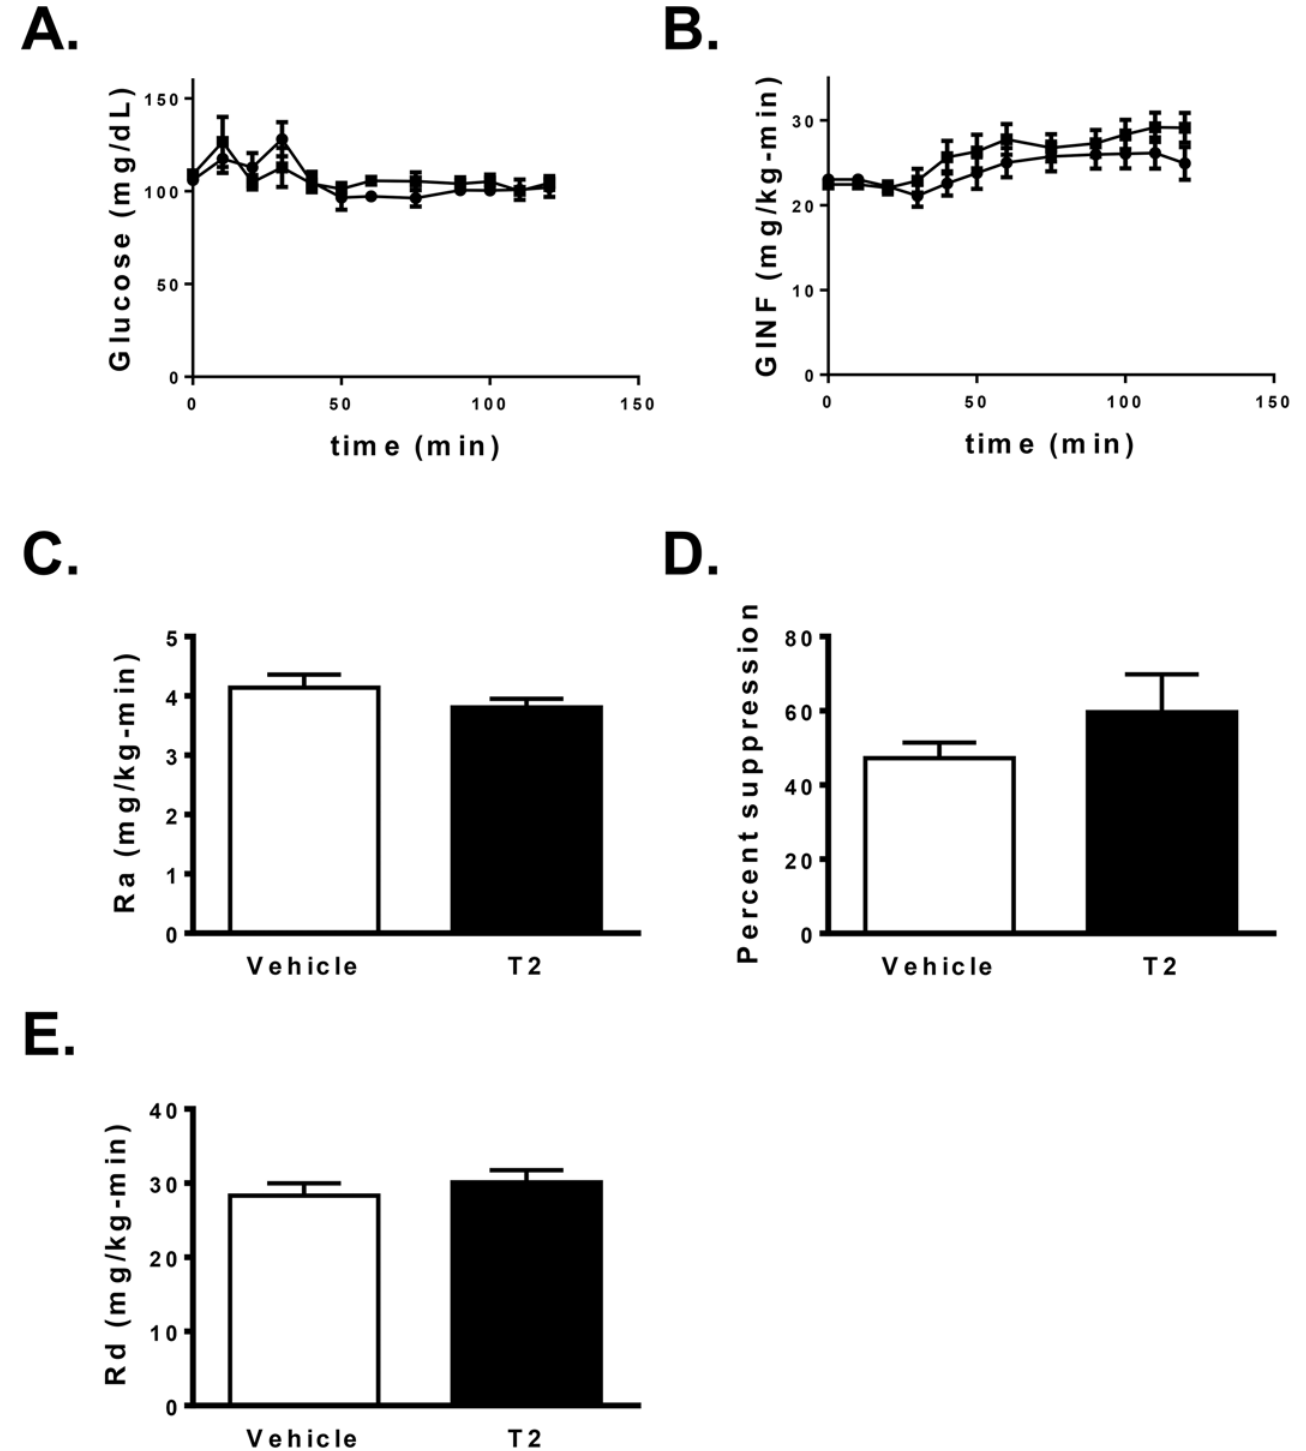
Fig 1. Assessment of tissue specific insulin sensitivity by hyperinsulinemic-euglycemic clamp, comparison between ten days T2 treatment ( n = 10) vs. vehicle ( n = 8). A. Plasma glucose and B. glucose infusion rate during hyperinsulinemic-euglycemic clamp (circles = vehicle treatment; squares = T2 treatment). C. Endogenous glucose production under basal conditions (white bars = vehicle; black bars = T2). D. Percent suppression of endogenous glucose production by insulin (4 mU/kg-min). E. Whole body insulin-stimulated glucose disposal.